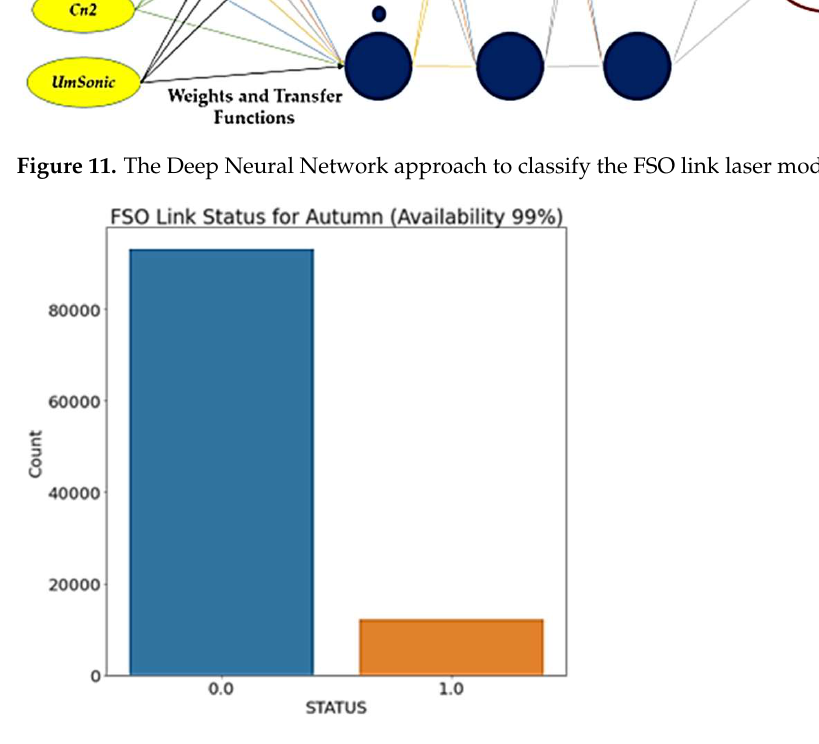
Figure 12. The cumulative results of the FSO operational status for the Autumn season. “0” for non-functional and “1” for functional laser operation.